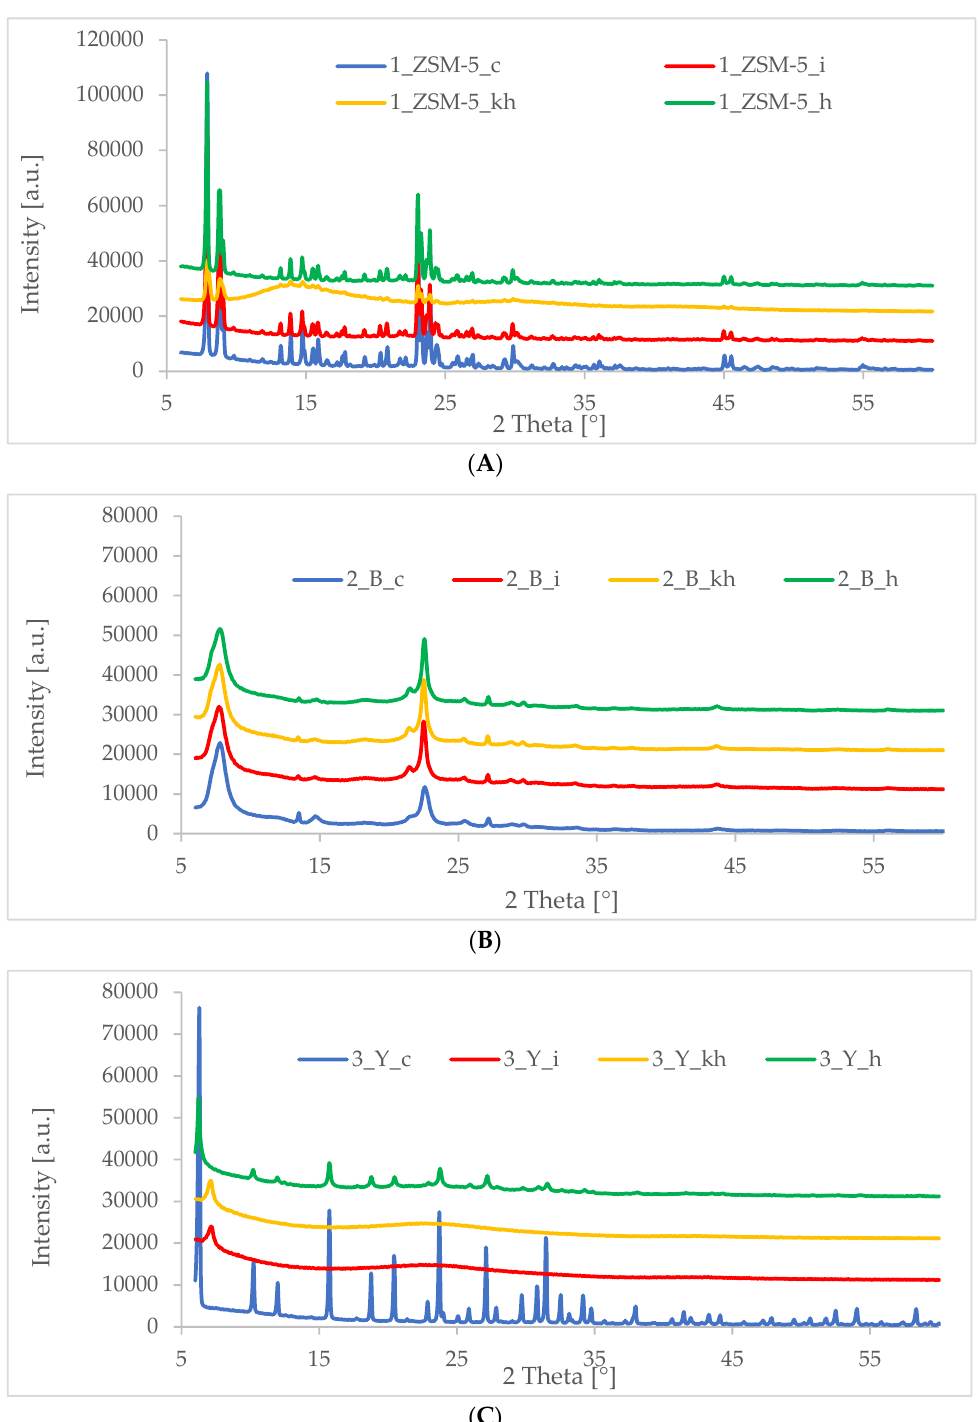
Figure 3. Diffractograms in wide-angle range of hierarchical materials: ( A ) based on commercial zeolite of ZSM-5 type (1_ZSM-5_c—commercial zeolite, 1_ZSM-5_i—inulin modified material, 1- ZSM-5_kh—hyaluronic acid modified material, 1_ZSM-5_h—heparin modified material); ( B )